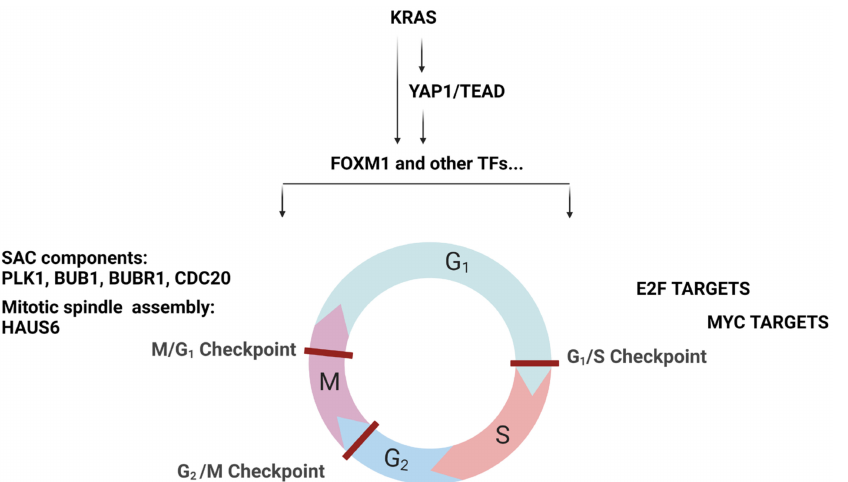
Figure 7. Potential molecular mechanisms explaining the crosstalk between KRAS and YAP1-TEAD. On the left-hand side of the panel, we propose that KRAS and YAP1-TEAD signaling converges essentially on the regulation of transcriptional activity of FOXM1, which in turn regulates some components of the SAC impacting the G2/M and M/G1 checkpoints. On the right-hand side of the panel, we propose that KRAS and YAP1-TEAD signaling may act on the E2F and MYC targets (via ATAD2 and HELLS). The modulation here may affect the G1/S